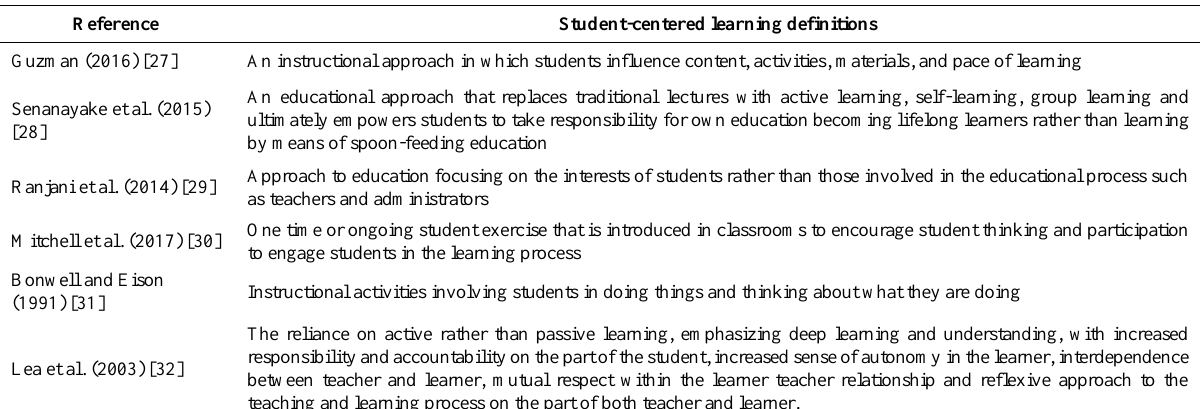
Table 1. Student-centered learning